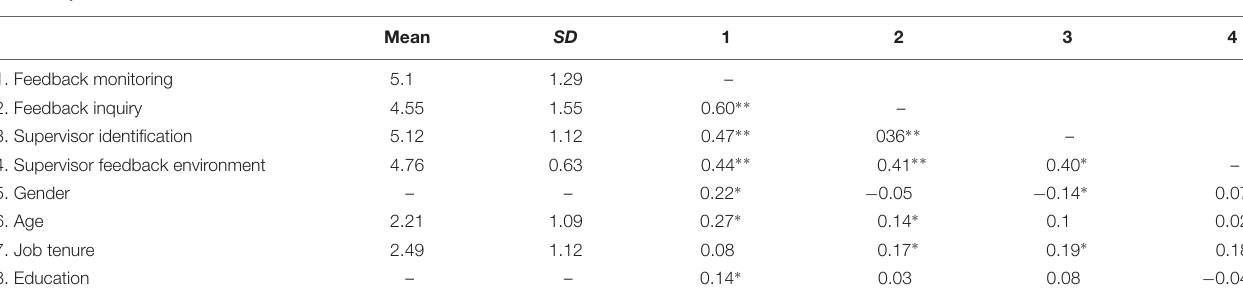
TABLE 2 | Means, standard deviations, and correlations of all